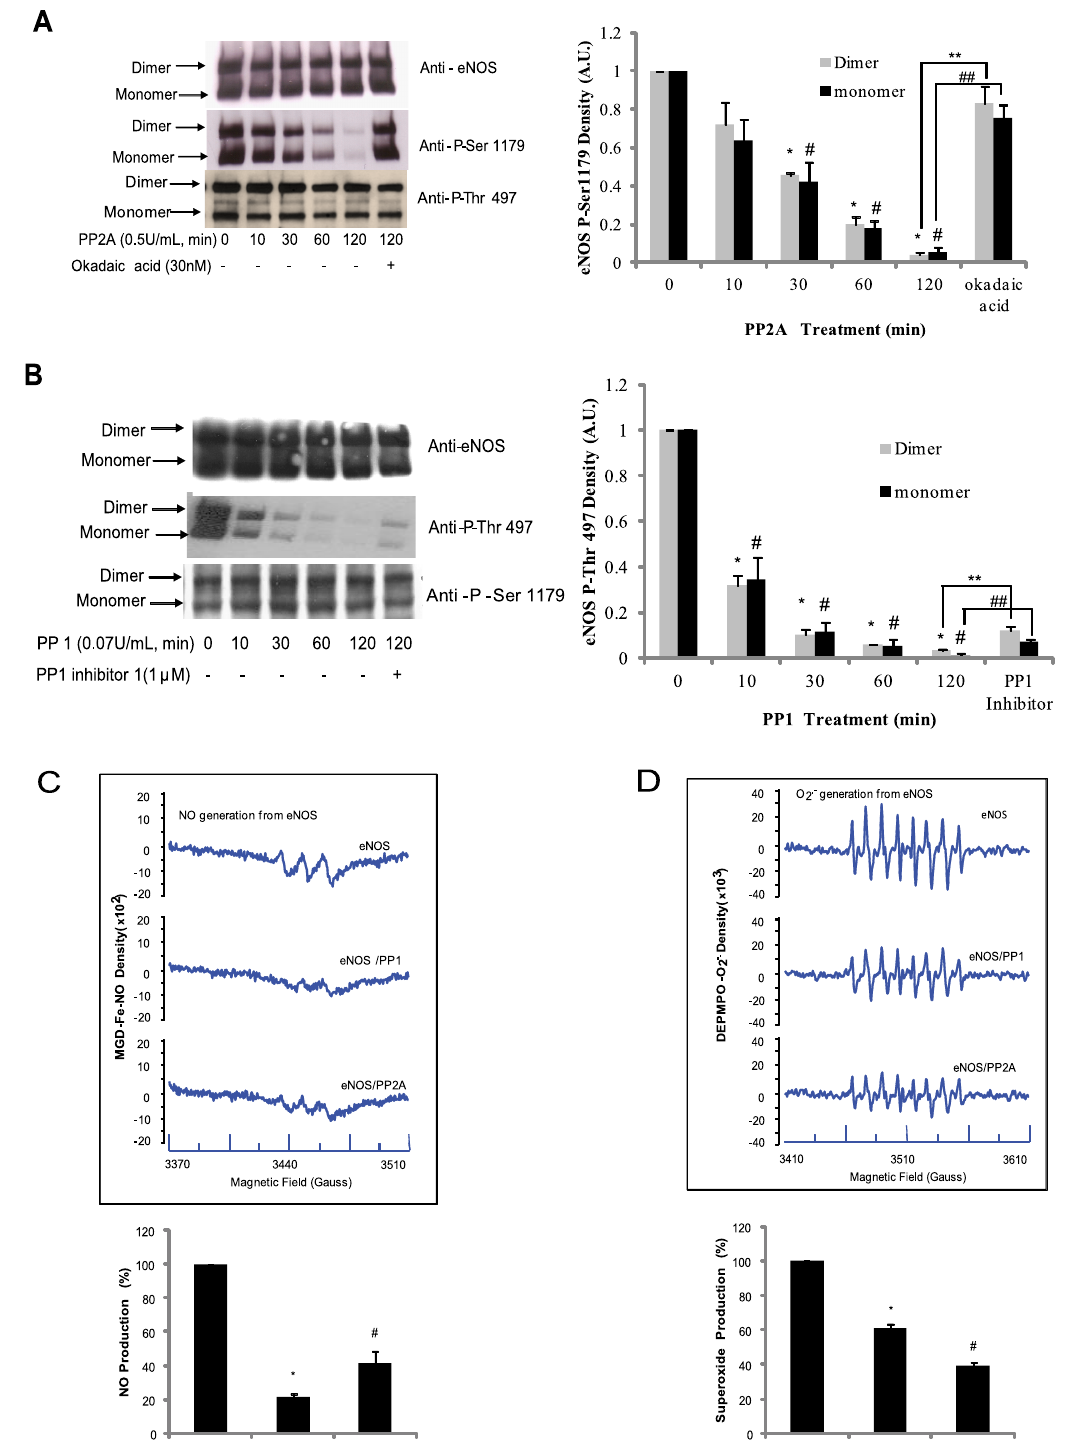
Figure 1. Dephosphorylation of Serine 1179 and Threonine 497 changed eNOS activity without affecting eNOS structure. (A) 2 m g purified bovine eNOS was incubated with PP2A for indicated time in the absence or presence of 30 nM okadaic acid. The eNOS sample was run on SDS-PAGE gel at low temperature. Ser1179 and Thr497 phosphorylation status was assessed. The Ser1179 phosphorylation signal in eNOS dimer and monomer was determined by densitometry and represented a bar graph. *P , 0.05 by one way ANOVA relative to control for dimers and # P , 0.05 for monomers. **P , 0.05 for okadaic acid with PP2A treatment vs. PP2A alone for dimers and ## P , 0.05 for monomers. (B) 2 m g purified bovine eNOS was incubated with PP1 in the presence or absence of 1 m M PP1 inhibitor 1. The mixtures were run on SDS-PAGE gel at low temperature and blotted with indicated antibodies *P , 0.05 by one way ANOVA relative to control for dimers and # P , 0.05 for monomers. **P , 0.05 PP1 with PP1 inhibitor treatment vs PP1 alone for dimers and ## P , 0.05 for monomers. (C) 2 m g purified eNOS was incubated PP2A or PP1 for 2 hours on ice and then